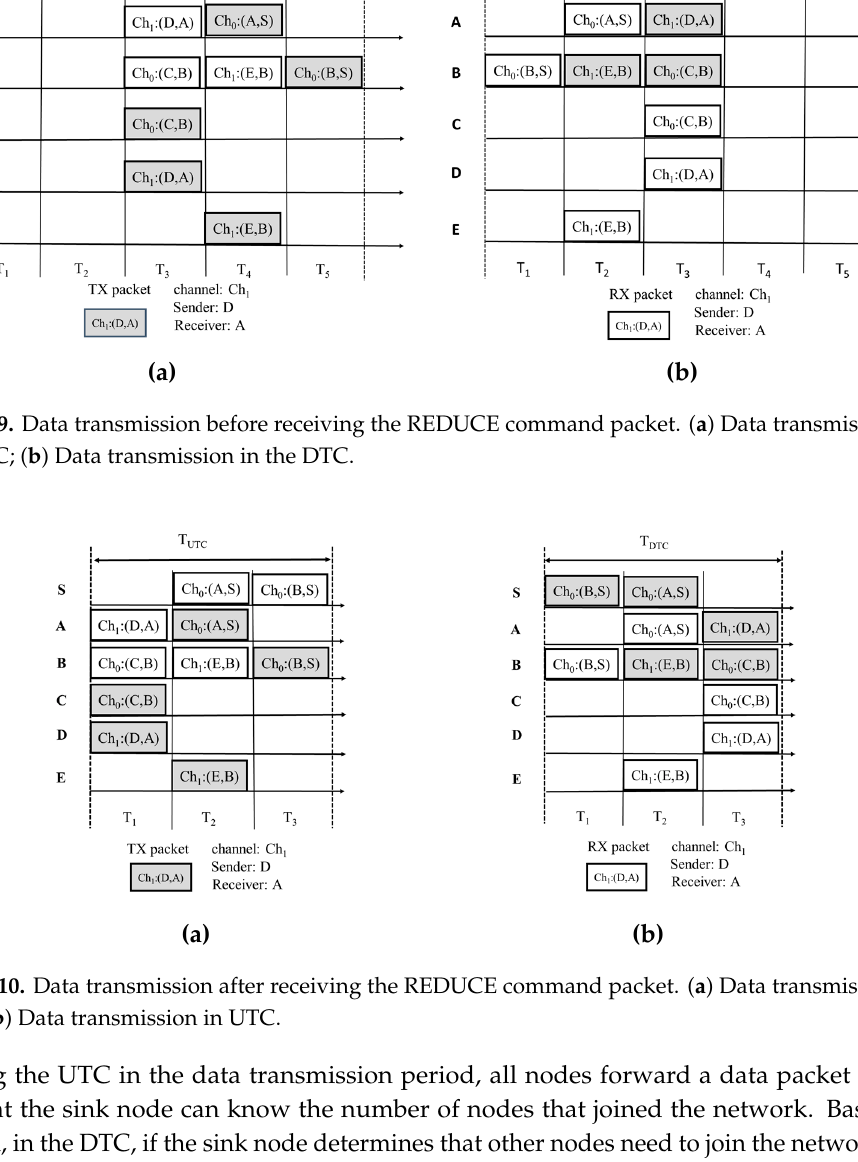
Figure 10. Data transmission after receiving the REDUCE command packet. ( a ) Data transmission in UTC; ( b ) Data transmission in UTC.